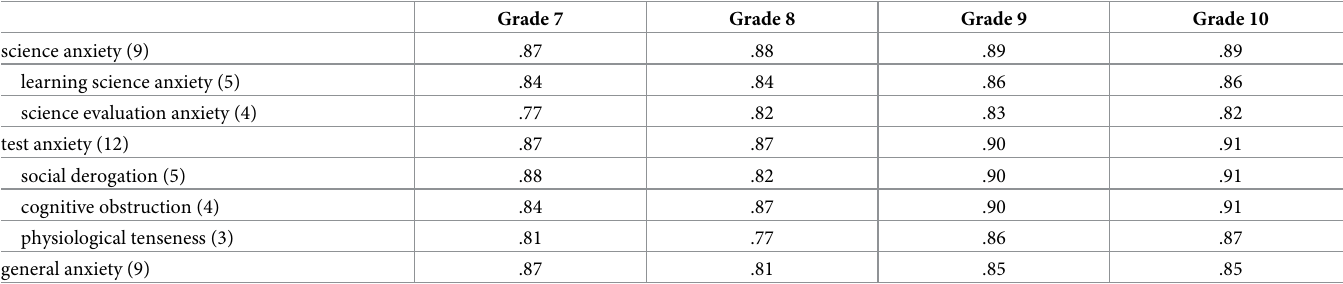
Fig 1. The factor structure of the ASAS in Study 1. SA = science anxiety; LSA learning science anxiety; SEA = science evaluation anxiety. https://doi.org/10.1371/journal.pone.0245200.g001 (165) = .67, p � 0.001 (.57 –.76, 95% CI); Grade 9, r (186) = .64, p � 0.001(.54 –.73, 95% CI); Grade 10, r (189) = .63, p � 0.001 (.52 –.73, 95% CI). Test score distributions. Fig 3 shows the distributions of test scores. One-Sample Kolmo- gorov-Smirnov Tests showed that the distributions of SA, LSA, and SEA test results across the whole sample ( N = 710) were normal, with means of 21, 10.2 and 10.8 (respectively) and stan- dard deviations of 8.7, 5.1, and 4.5 (respectively), p’s (Lilliefors Corrected) � 0.001. As shown in Fig 3, students’ responses ranged from 9 to 45 (for the total score), from 5 to 25 (for LSA), and from 4 to 20 (for SEA). Gender and grade differences. Fig 4 shows means, with error bars representing standard errors, of students’ responses on the ASAS, test anxiety, general anxiety, and science achievement. Table 2. McDonald’s ω reliability rates of anxiety scales in Study